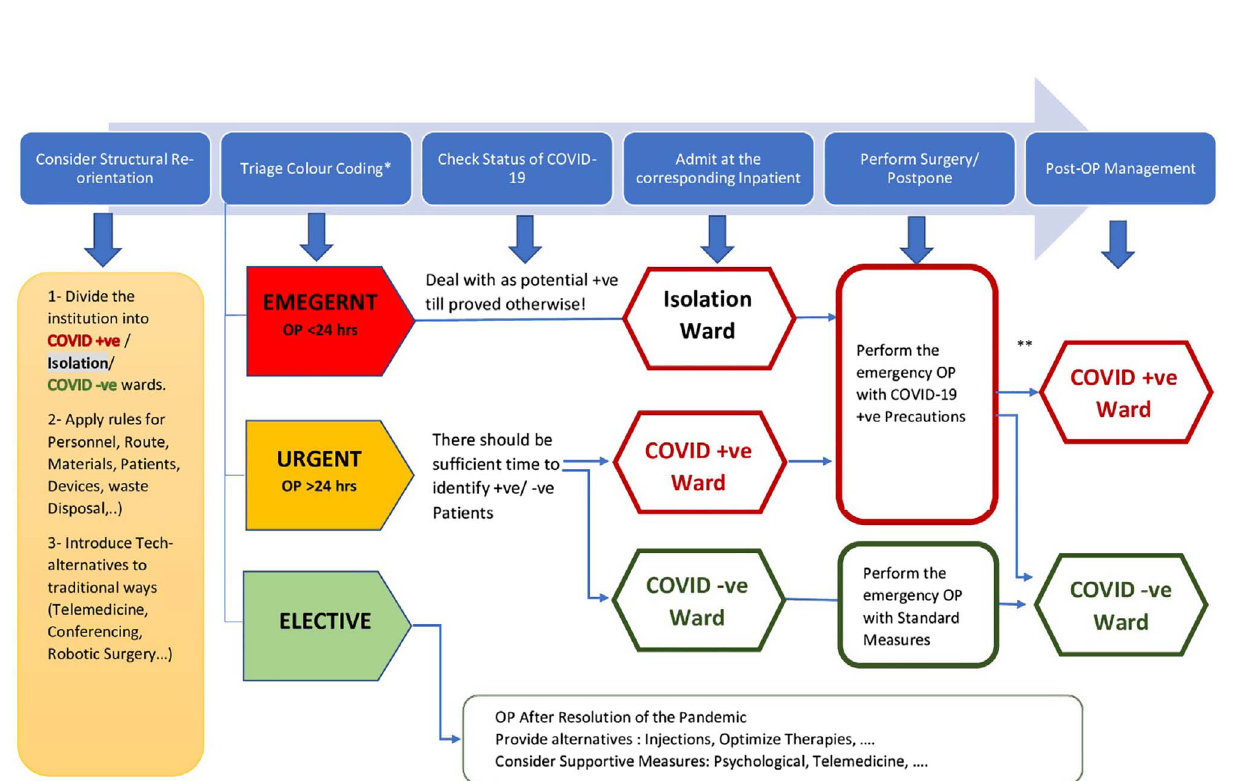
Figure 2. Suggested Flowchart for dealing with orthopaedic and Trauma cases during the period of the COVID-19 Pandemic. *De fi ning the urgency of the condition is multifactorial and differs according to the institution, resources and patient characteristics (see text). **The emergency patients stay postoperatively in the Isolation Ward till available test results for COVID-19